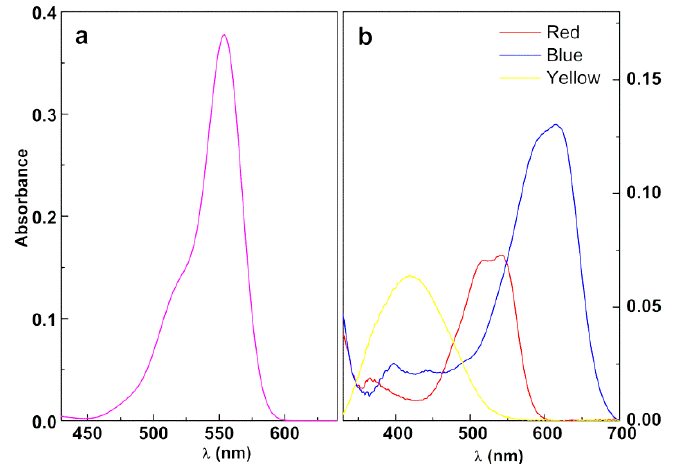
Figure 6. UV-Visible absorption spectra of aqueous solutions of ( a ) Rhodamine B (40 mg/L) and ( b ) industrial reactive dyes (80 mg/L). Red: C.I. Reactive Red 195; Blue: C.I. Reactive Blue 250; Yellow: C.I. Reactive Yellow 145.